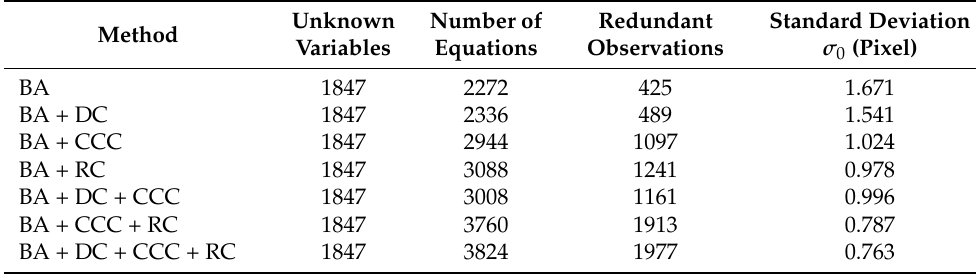
Table 8. Comparison of different model elements.